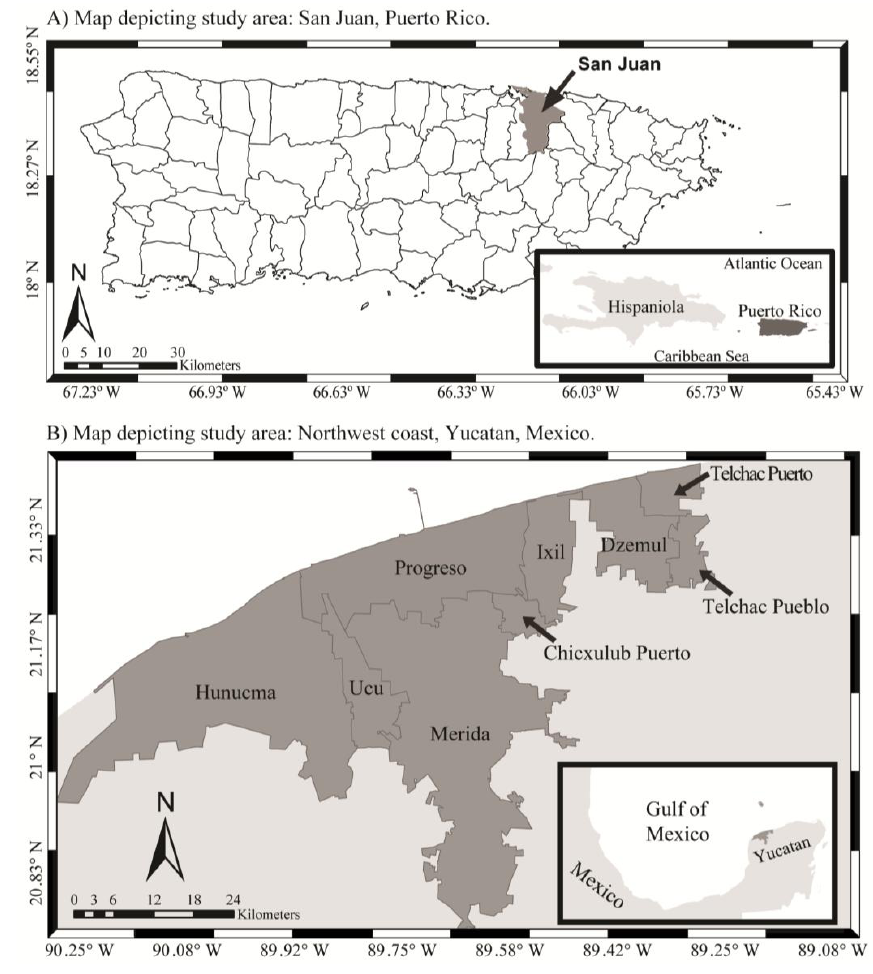
Figure 1. Map of locations of study areas. Maps depicting locations of the study areas in: ( A ) the municipality of San Juan, Puerto Rico; and ( B ) northwest coast of the Yucatan Peninsula, Mexico.